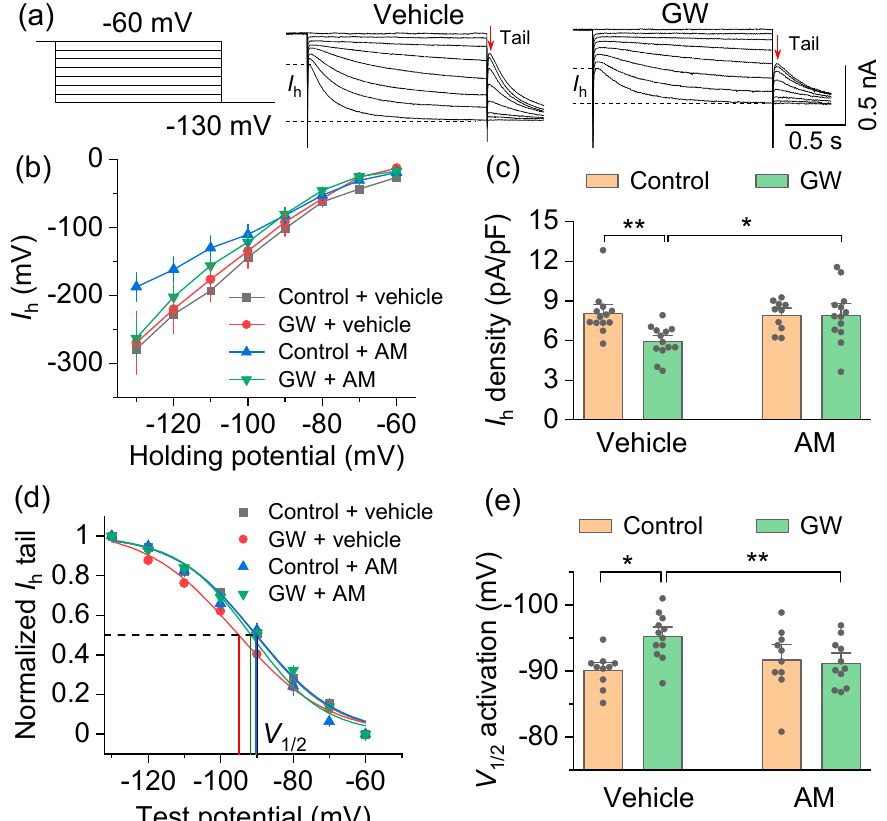
Figure 3. Activation of the CB2 receptor decreased HCN currents (I h ) in SNc dopamine neurons. ( a ) Left, A hyperpolarizing voltage step protocol used to induce I h . Right, representative I h traces from SNc dopamine neurons following bath application of GW842166x (GW) or control. ( b ) I–V relationship of I h recorded from different treatment groups. ( c ) I h density was significantly decreased by bath application of GW compared to vehicle (** p = 0.007, n = 13 cells from 4 mice), and the GW- induced decrease in I h density was blocked by AM pretreatment (* p = 0.012, n = 13 cells from 4 mice). ( d ) I h activation curves generated by the tail current protocol in SNc dopamine neurons. ( e ) Bath application of GW led to a hyperpolarizing shift in the half-activation potential ( V 1/2 ) compared with control (* p = 0.011, n = 10–12 cells from 4 mice), and this shift was prevented by AM preincubation (** p = 0.001, n = 10–11 cells from 4 mice).